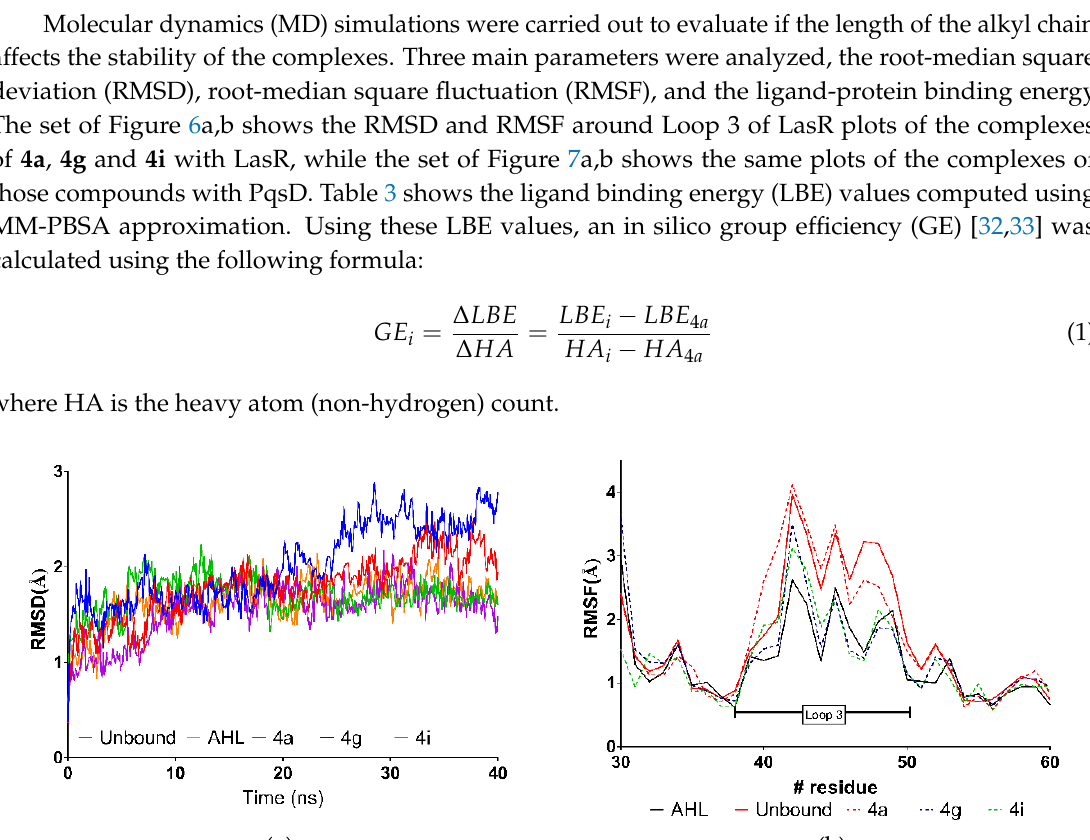
Table 3. Average RMSD values and ligand binding energy (LBE) 1 calculated during MD simulations.